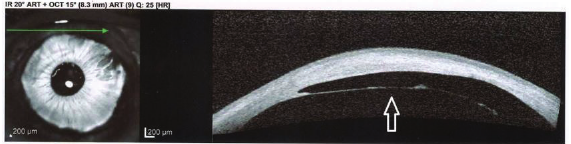
Figure 4: SPECTRALIS SD-OCT photograph of left eye demon- strating complete detachment of Descemet’s membrane (white arrow